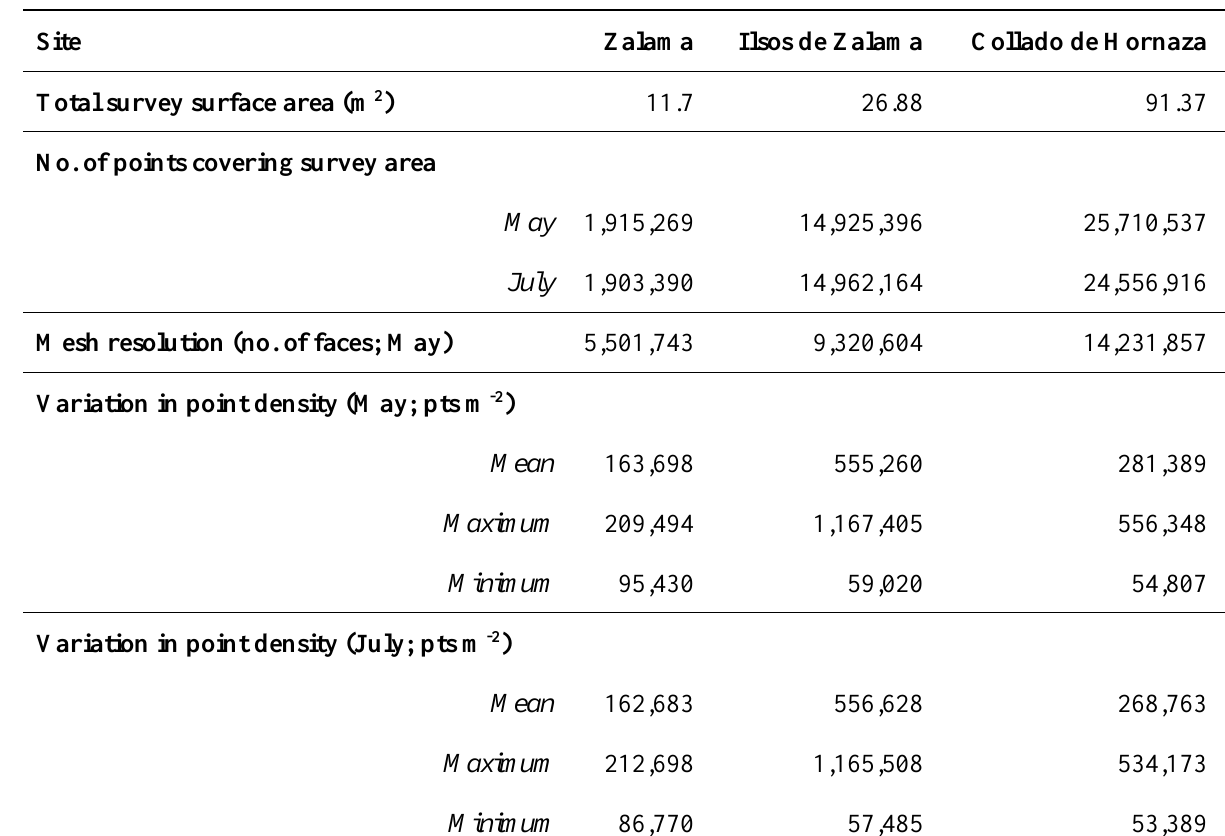
Table 1. Survey area, point density and mesh